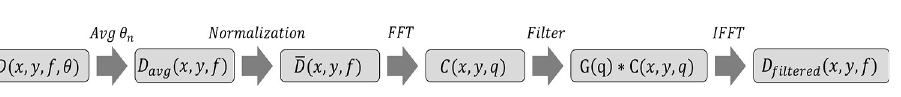
Fig 2. Signal processing flowchart. The flowchart describes the signal processing steps taken during the cepstrum analysis.